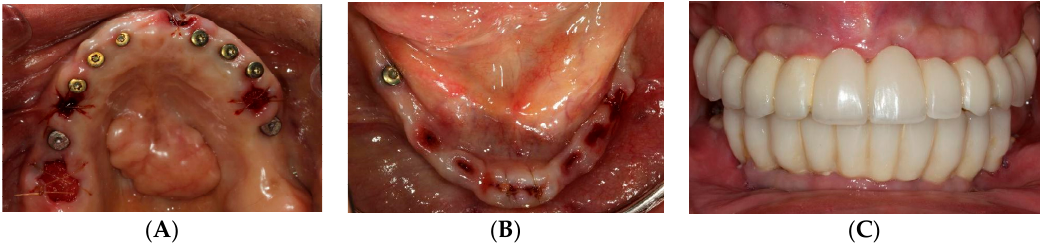
Figure 5. Second stage strategic extraction and conversion of fixed provisional prosthesis. Extraction of remaining abutment teeth. (A) Maxillary view. ( B ) Mandibular view. ( C ) Converted implant-supported provisional prosthesis.